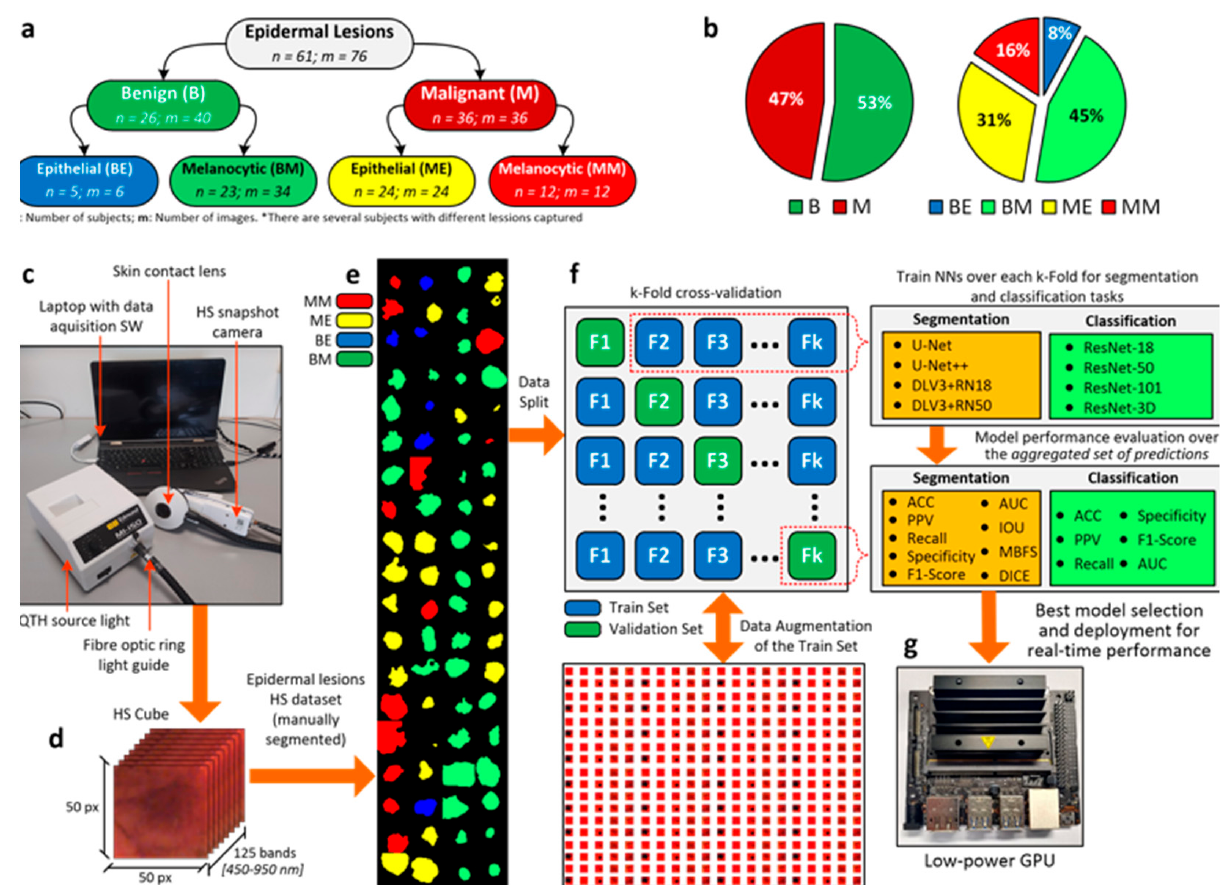
Figure 1. Proposed experimental framework. ( a ) Taxonomy of the epidermal lesions included in the HS database, including number of subjects and images in each category; ( b ) Distribution of images for the binary (left) and multilabel (right) classification problems; ( c ) Different elements of the HS acquisition system; ( d ) HS cube characteristics; ( e ) HS dataset ground-truths; ( f ) Proposed processing framework based on a k-fold cross-validation, including data augmentation and aggregated model evaluation; ( g ) Low-power Nvidia Jetson GPU for algorithm deployment to reach real-time performance.